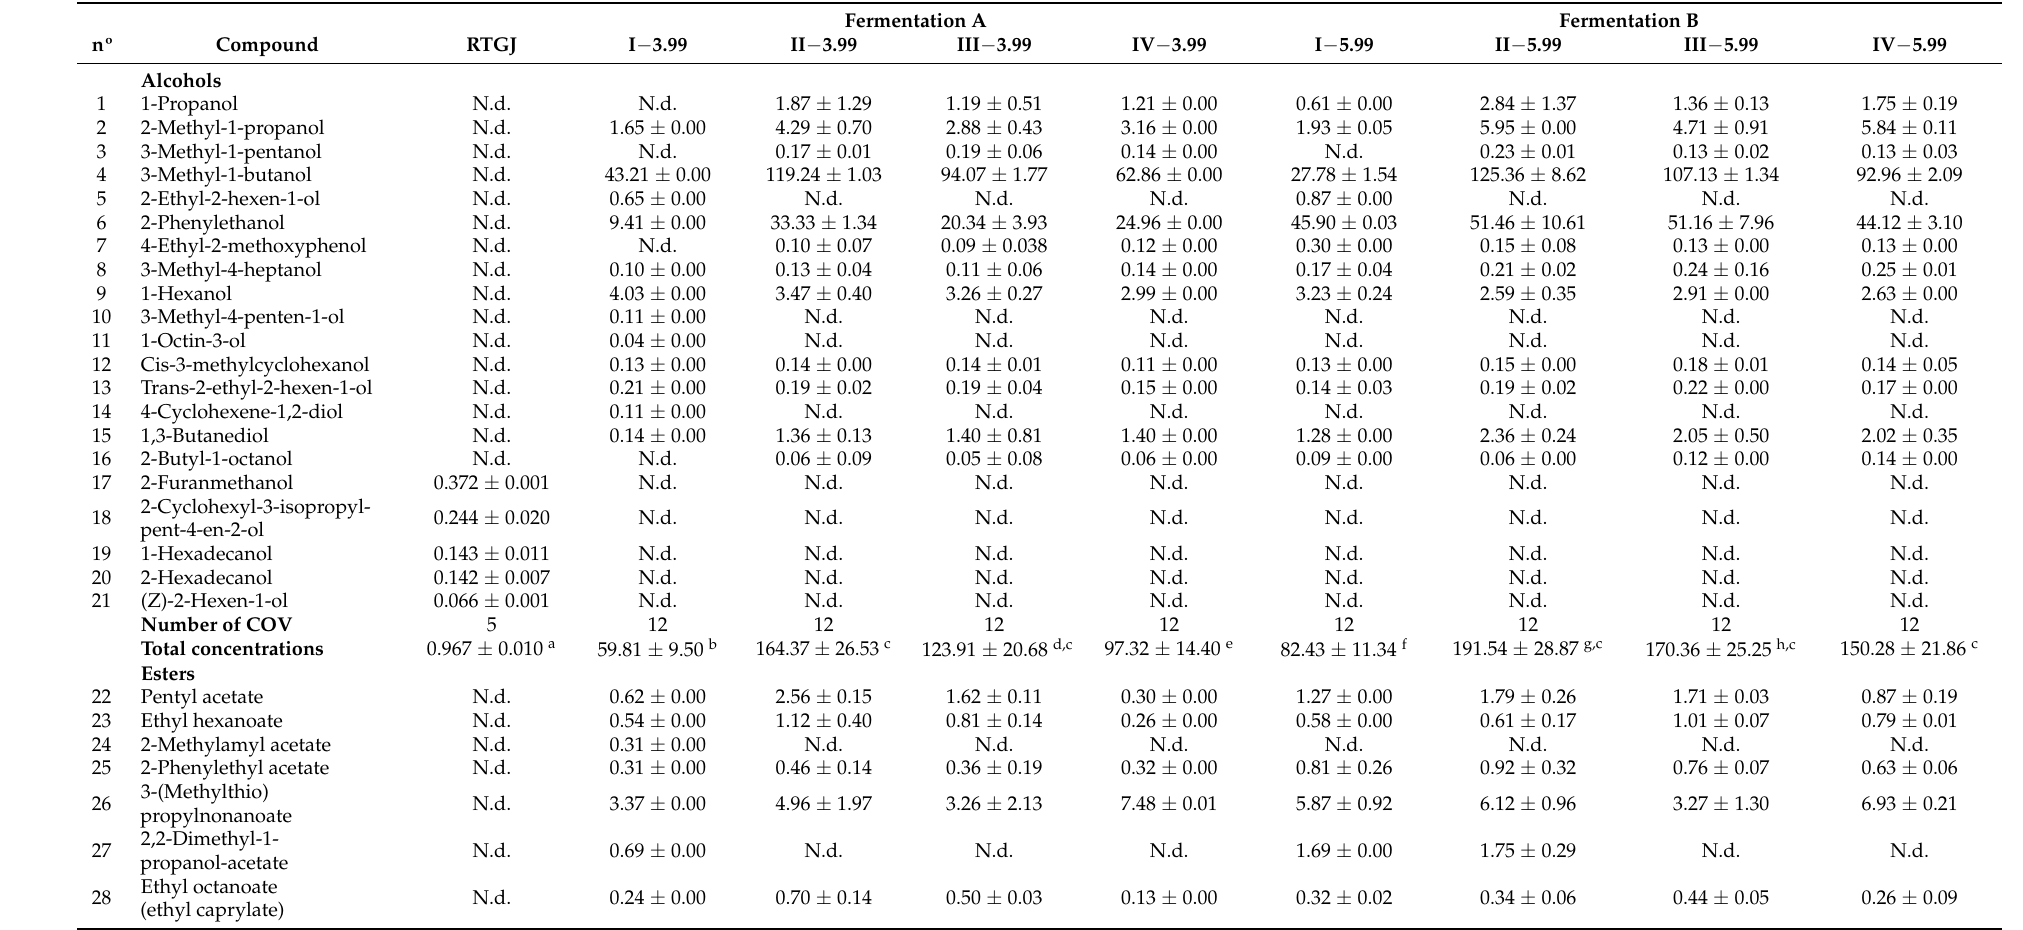
Table 6. Mean Concentrations (mg/L) and Standard Deviations of the Volatile Organic Compounds Detected in the Nonfermented Red Table Grape Juice (RTGJ) and in Different Kefir-like Beverages Obtained from the Four Subcultures in Fed-batch Fermentation A (I − 3.99, II − 3.99, III − 3.99 and IV − 3.99) and B (I − 5.99, II − 5.99, III − 5.99, and IV − 5.99). Results Are Shown as Means ± Standard Deviations of Two Experiments and Three Analytical Replications